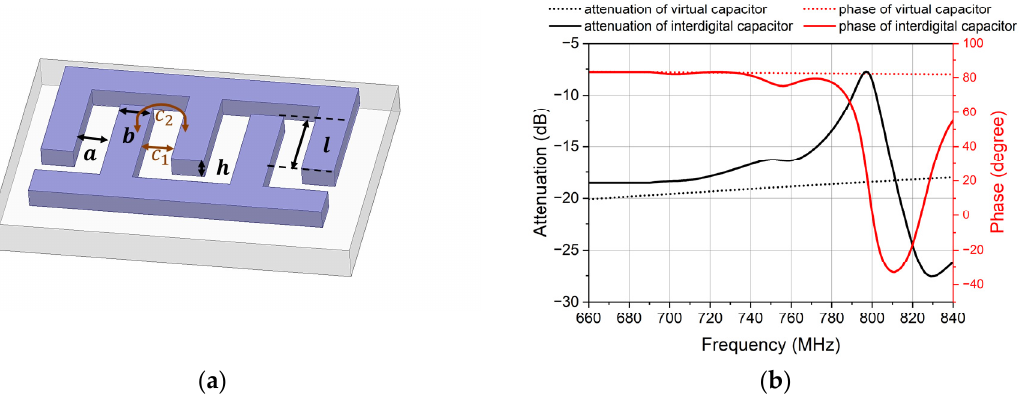
Figure 8. The paraments of the attenuator. ( a ) The structure of the interdigital capacitor. C 1 is the capacitance between the electrodes, and C 2 is the capacitance generated by the edge of electrodes. ( b ) The attenuation and phase of the virtual capacitor and interdigital capacitor.